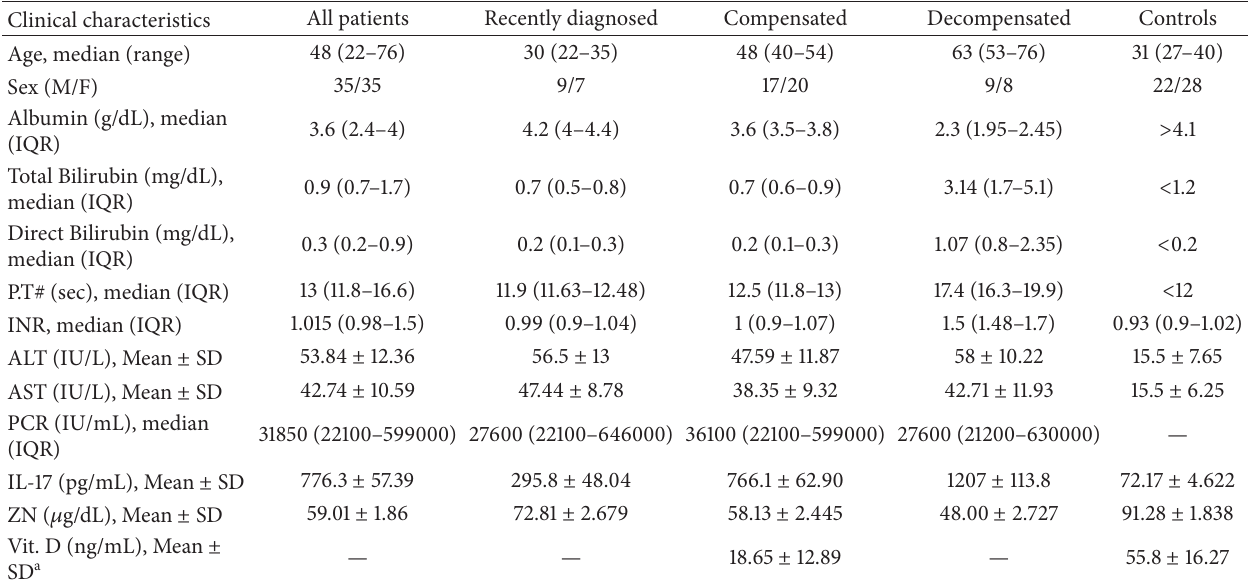
Table 1: Demographical and clinical characteristic of patients and controls.